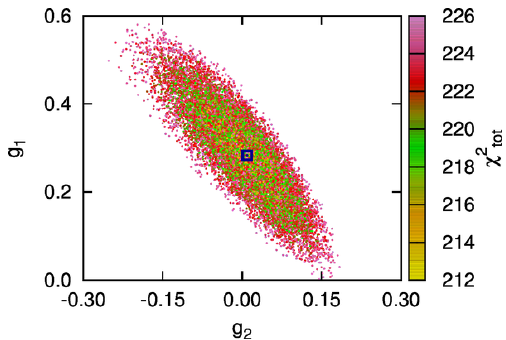
Figure 12 . Scatter plots showing the correlation between the g 1 and g 2 free parameters of eq. (5.1). The (cid:31) 2 corresponding to this (cid:12)t is colour-coded: yellow corresponds to its lowest values while red tot and purple to the highest accepted